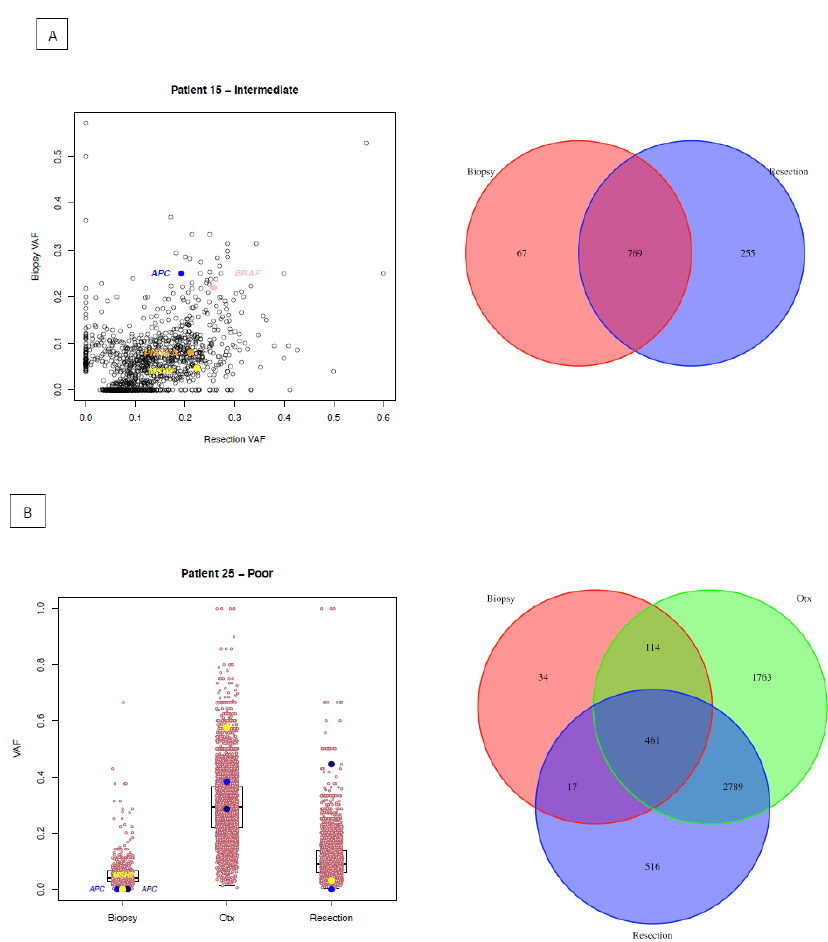
Figure 3. Patients with potential selection of microsatellite instability. ( A ) Patient 15. Left panel: Scatterplots comparing Variant Allele Frequencies (VAFs) of all SNVs (black circles) and likely driver mutations (coloured circles) in the pre-treatment biopsy and post-treatment surgical resection tumour sample. Right column: Venn diagram of all SNVs from different time points. ( B ) Patient 25. Left panel: Boxplots of Variant Allele Frequencies (VAFs) of all SNVs (black circles) and likely driver mutations (coloured circles) in multiple tumour samples. Right column: Venn diagram of all SNVs from di ff erent time